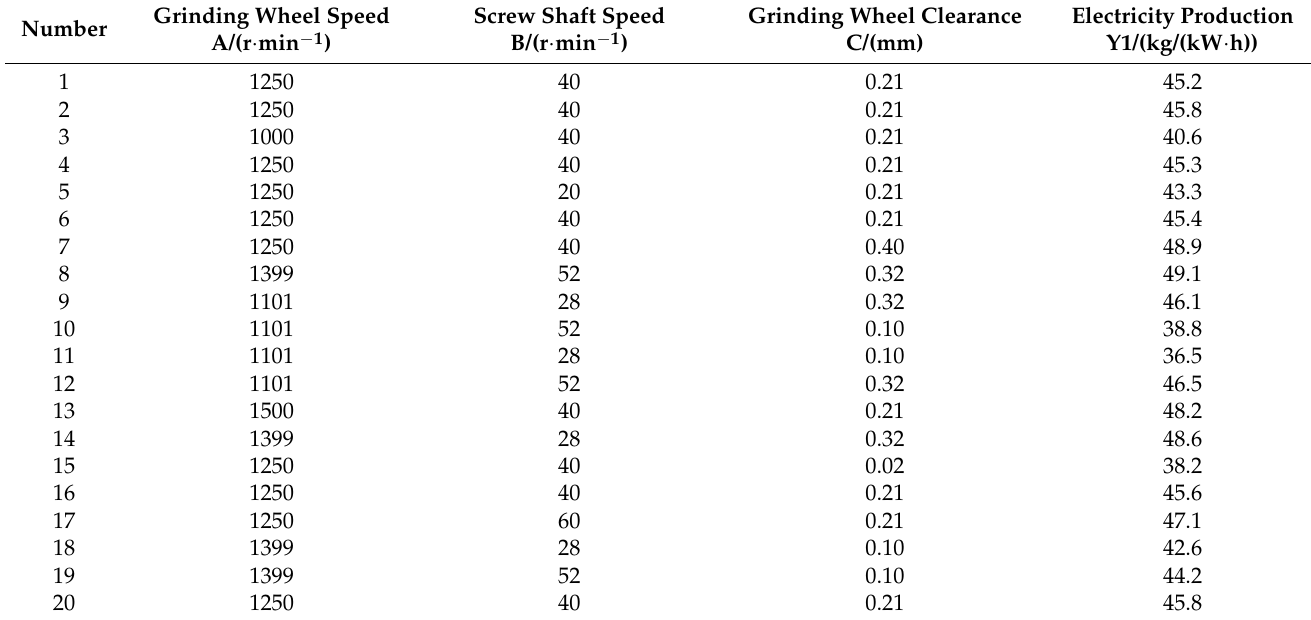
Table 3. Central composite test design and